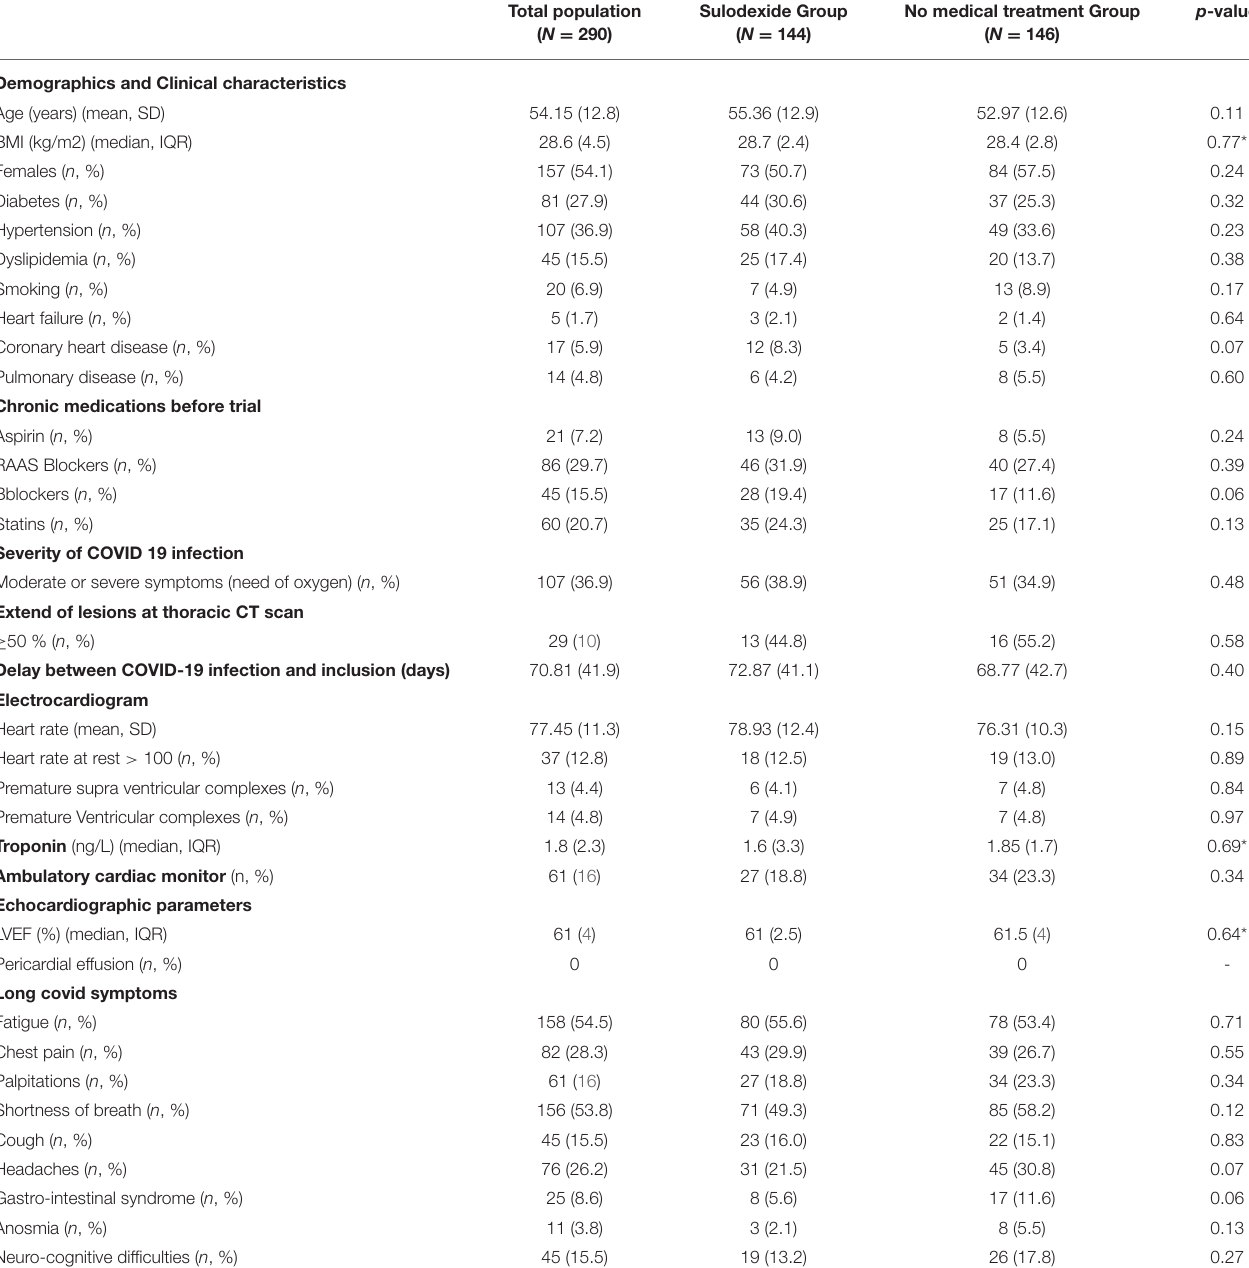
TABLE 1 | Baseline characteristics of the study population.